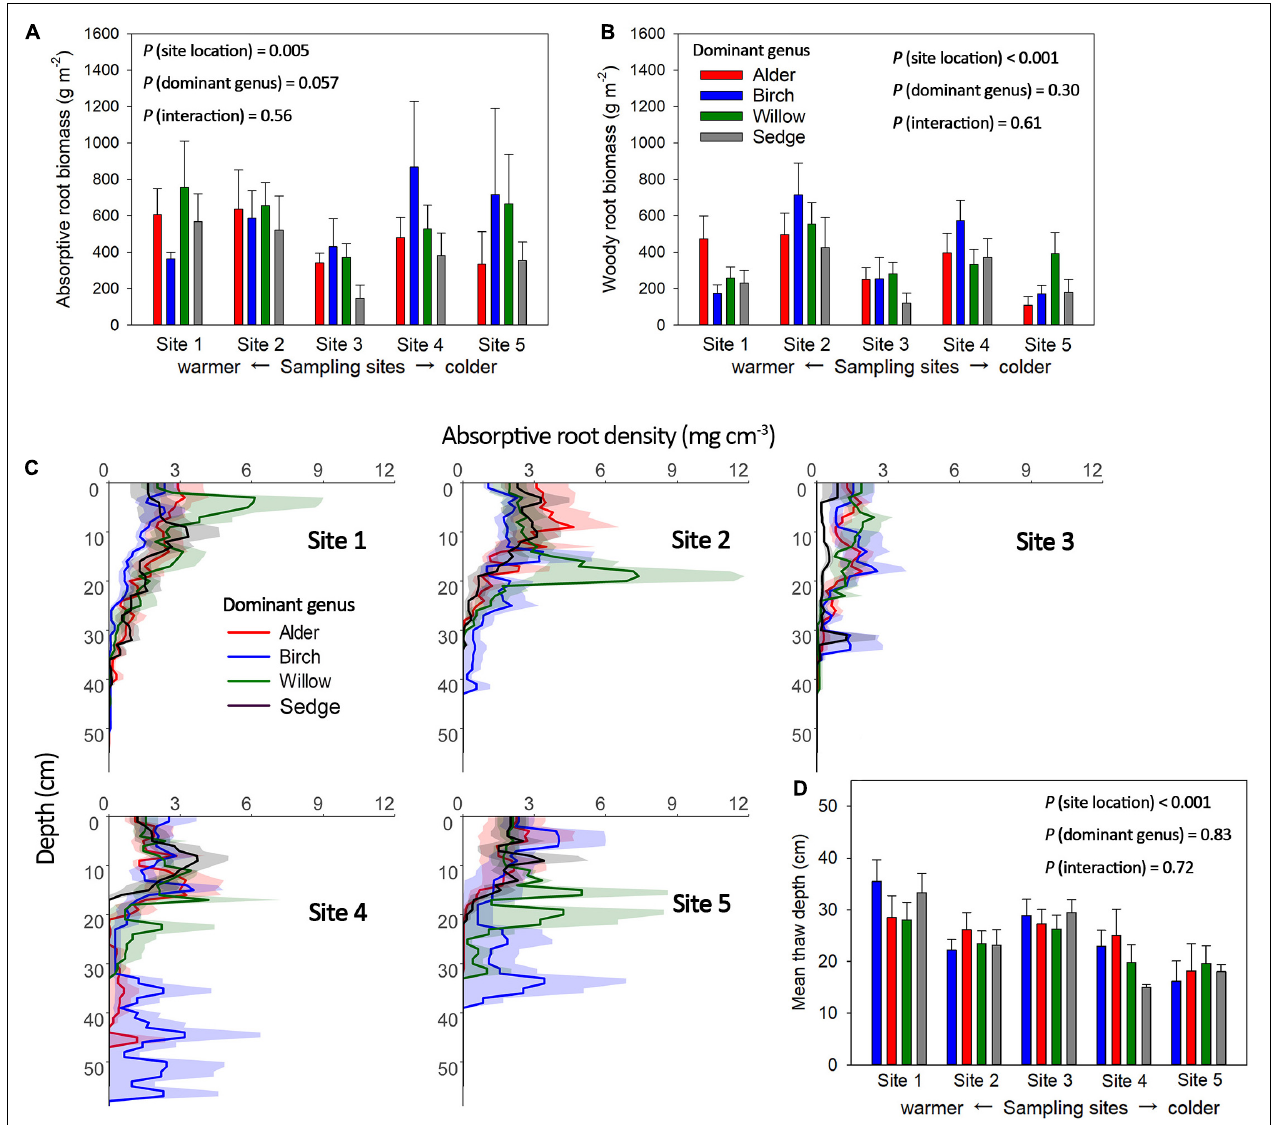
FIGURE 3 | Accumulative absorptive (A) and woody (B) root biomass in the active soil layer, and vertical distribution of absorptive root biomass from the soil surface (moss excluded) to the top of the permafrost layer (C) of the plots with four different dominant genera across the five sampling sites. Mean thaw depth for plots with the same dominant genus at each site were also shown (D) . Shaded area and error bars indicate ± 1 S.E. Accumulative absorptive root biomass was significantly influenced by sampling site location ( P = 0.005, Site 2 > Sites 3, 5; Site 1 > Site 3) and marginally influenced by dominant genus ( P = 0.057). Woody root biomass was significantly influenced by only site location ( P < 0.001, Site 2 > Sites 1, 3, 4, 5; Site 4 > Site 3). Mean thaw depth were significantly influenced by site location ( P < 0.001, Site 1 > Sites 2, 4, 5; Site 3 > Sites 4, 5). There are more deep roots ( > 20cm) in shrub (mainly birch) dominated plots than sedge dominated plots in Site 4 and 5 ( P =